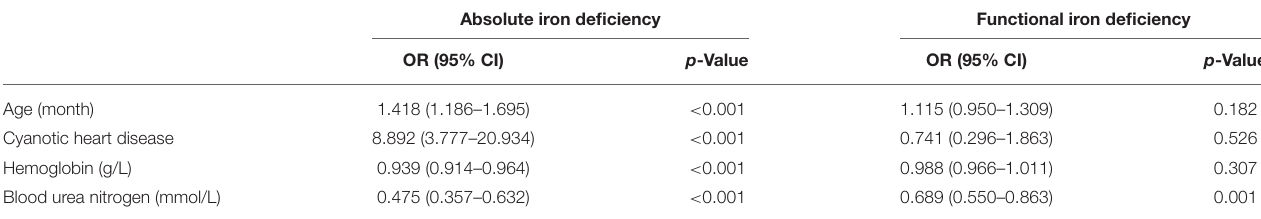
TABLE 2 | Multiple logistic regression for iron